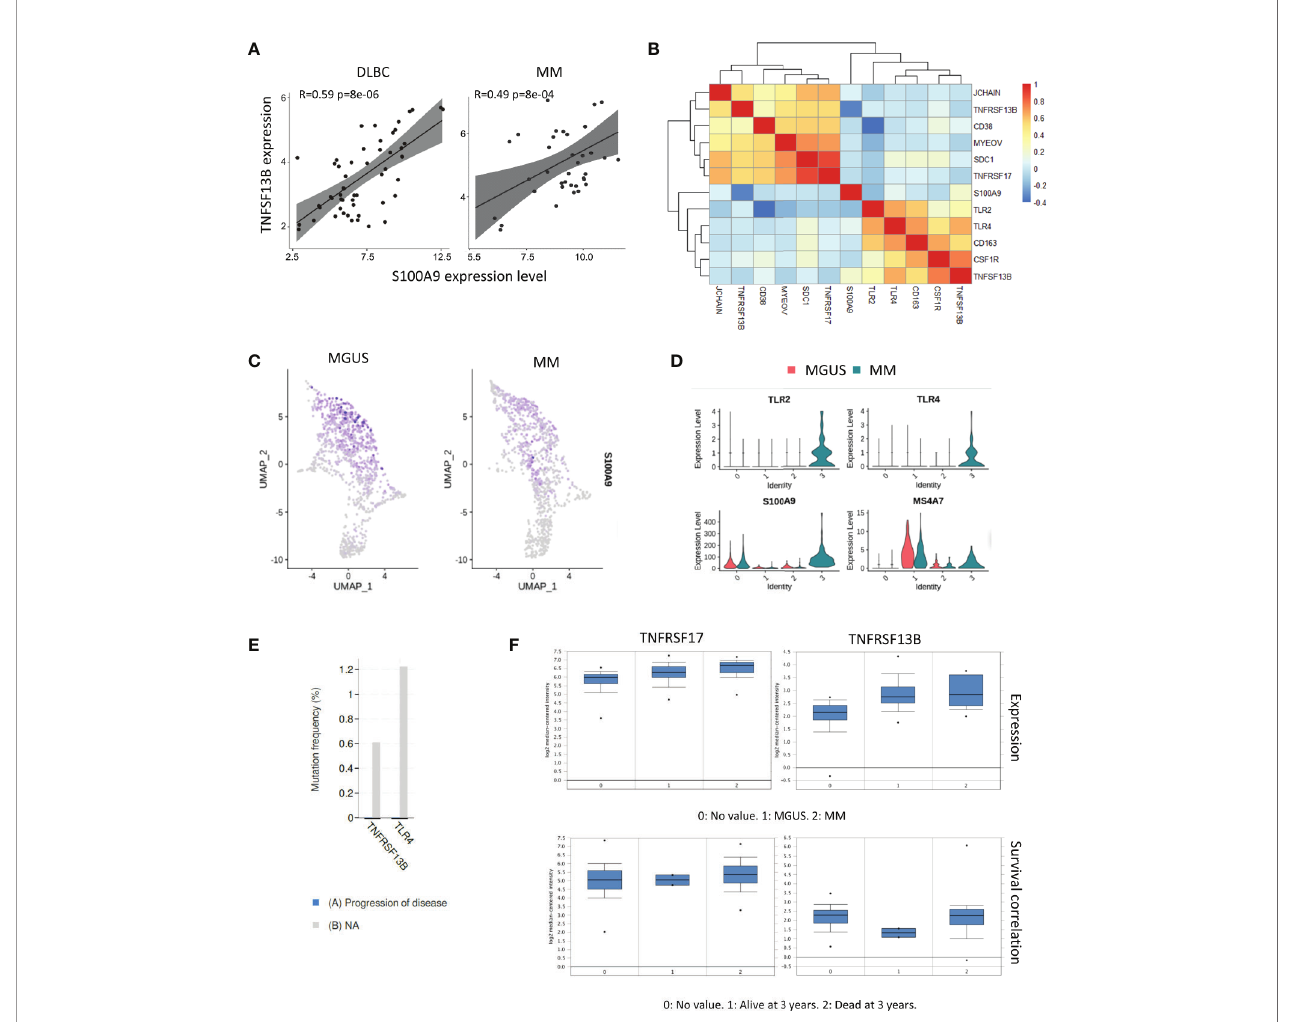
FIGURE 2 | Correlation between TNFSF13B and S100A9 signal. (A) Scatter plots show the correlation between S100A9 and TNFSF13B expression in MM and DLBC samples. (B) Heatmap reveals the correlation between TNFSF13B related genes in myeloid cells and MM cells. (C) Feature plots show the projection of S100A9 expression onto the neutrophil and macrophages (D) Violin plots indicate the level of S100A9 expression in the neutrophil and macrophages. (E) In bar graphs, the progress of disease in the patient with TNFRSF13B and TLR4 mutant is quanti fi ed and compared. (F) Box plots demonstrate the correlation of TNFRSF13B and TNFRSF17 expression with MGUS and MM samples as well as their correlation with the 3-year survival